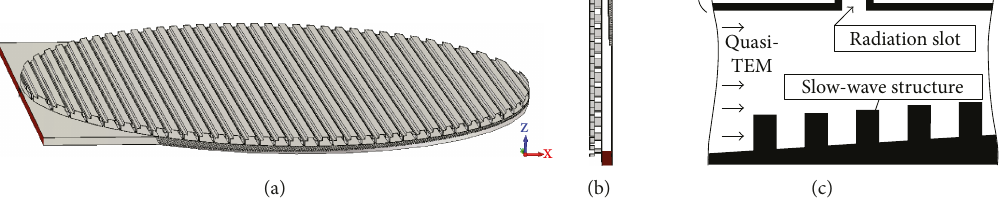
Figure 1: Radiating array of VICTS antenna: (a) 3D view, (b) side view, and (c) side view of VICTS